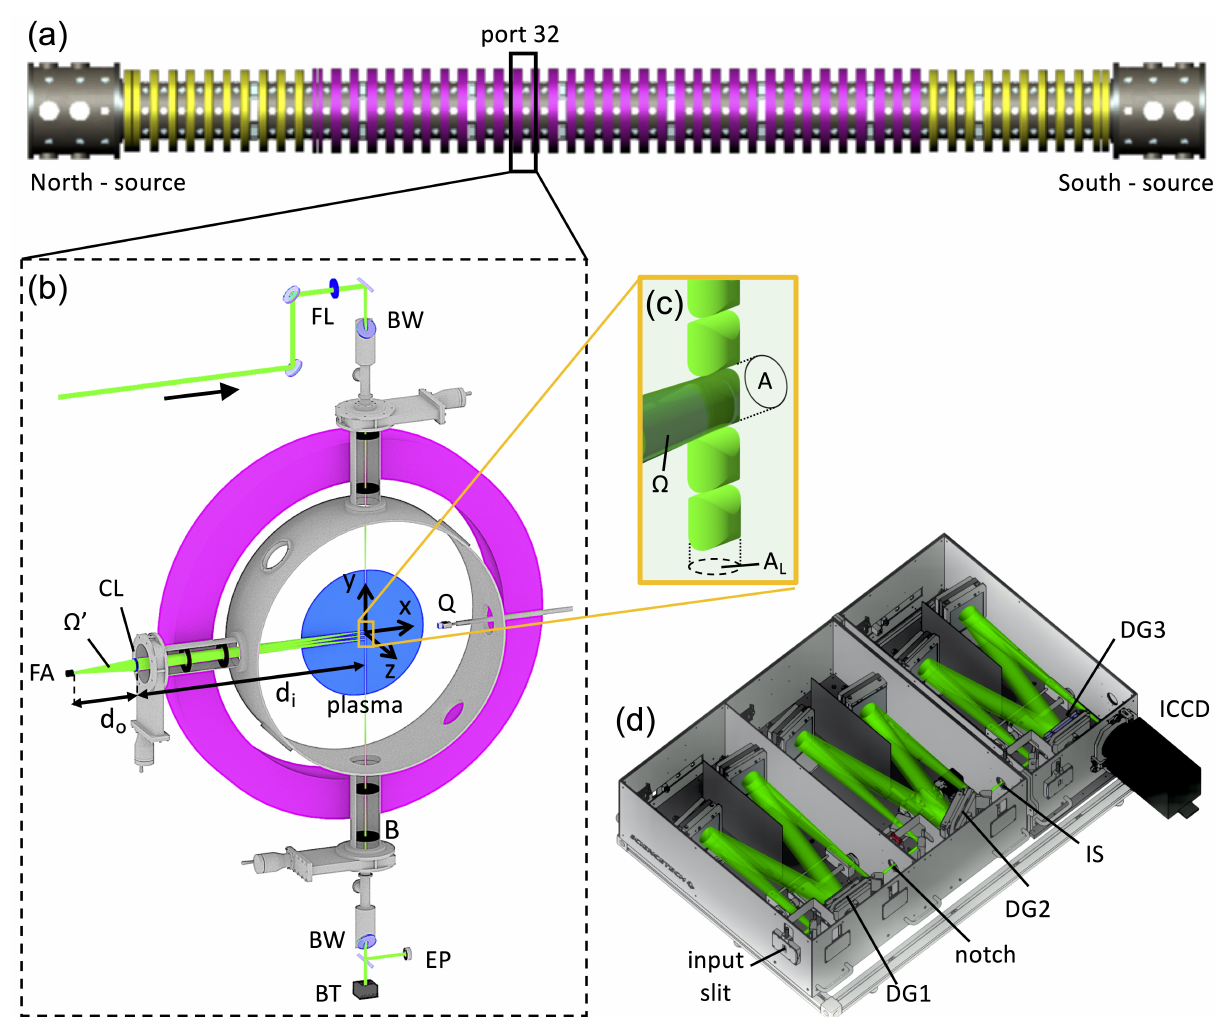
Figure 1. ( a ) Schematic layout of the 22 m long LAPD showing the two plasma sources on either end and the magnetic field coils (yellow and pink). The TS diagnostic is installed in port 32 as indicated by the box. ( b ) Detailed view of the segment around port 32. The TS probe beam is focused by a focusing lens (FL) before it enters the vessel through a Brewster window (BW) on top of the machine and is linearly polarized in the center of the plasma along the z-axis, perpendicular to the direction of the collected light. Scattered light is collected by a collection lens (CL) at a distance of d i from the scattering volume. The light collected in a solid angle Ω (cid:48) is then focused into a 40 × 200 µ m core fiber array (FA) located a distance of d o from the lens. Unscattered light exits the chamber through baffles (B) and a Brewster window (BW) and terminates in a beam trap (BT). A fraction of the transmitted light is measured with a pyroelectric energy pickup (EP) to monitor the total laser energy for each shot. A quartz-crystal probe (Q) can be inserted along the ˆ x axis and into the scattering volume using a motorized probe drive. ( c ) The scattering volume is defined by the intersection of the waist of the focused probe beam of cross-section A L and the projection of the fiber array onto the beam. The projected area of a single fiber at the beam is A . Only the path of the light collected by the central fiber with source solid angle Ω is shown. ( d ) The triple-grating spectrometer showing the light path from the input slit through the notch filter, the intermediate slit (IS) and onto the image intensified camera (ICCD) guided by internal mirrors and diffraction gratings (DG) along the way. To effectively discriminate the faint Thomson scattering signal from the much brighter unshifted stray light at λ i , either a volume Bragg grating (VBG) or a TGS is typically used. Compared to a VBG [25,26], a TGS provides the advantage of a flexible notch filter configuration at the expense of slightly lower system throughput [19]. Unlike